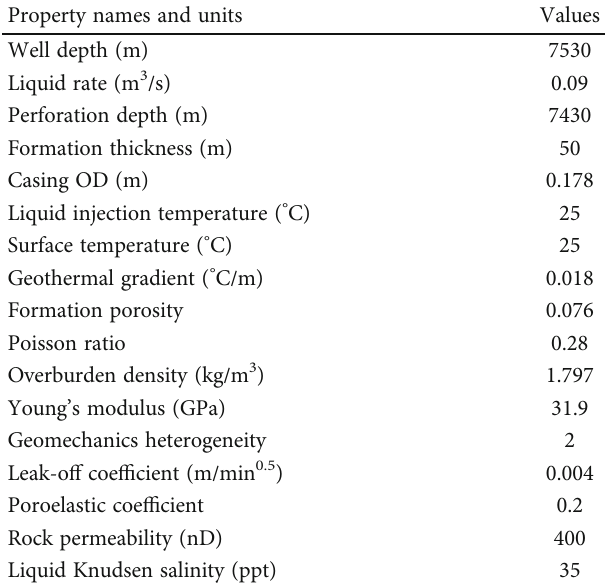
Table 1: Reservoir properties and fracking schedule for the case